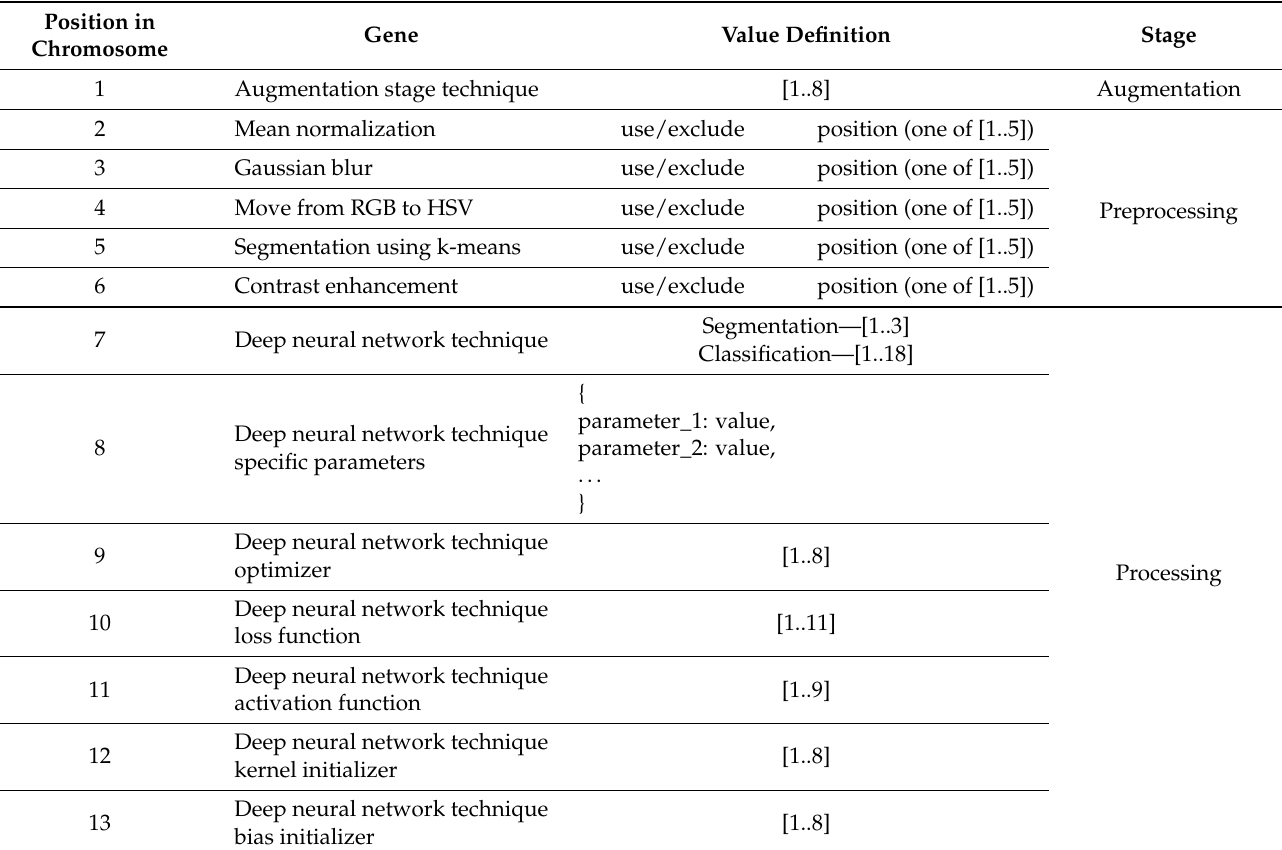
Table 1. Definition of the string representing the different design decisions for an image process- ing